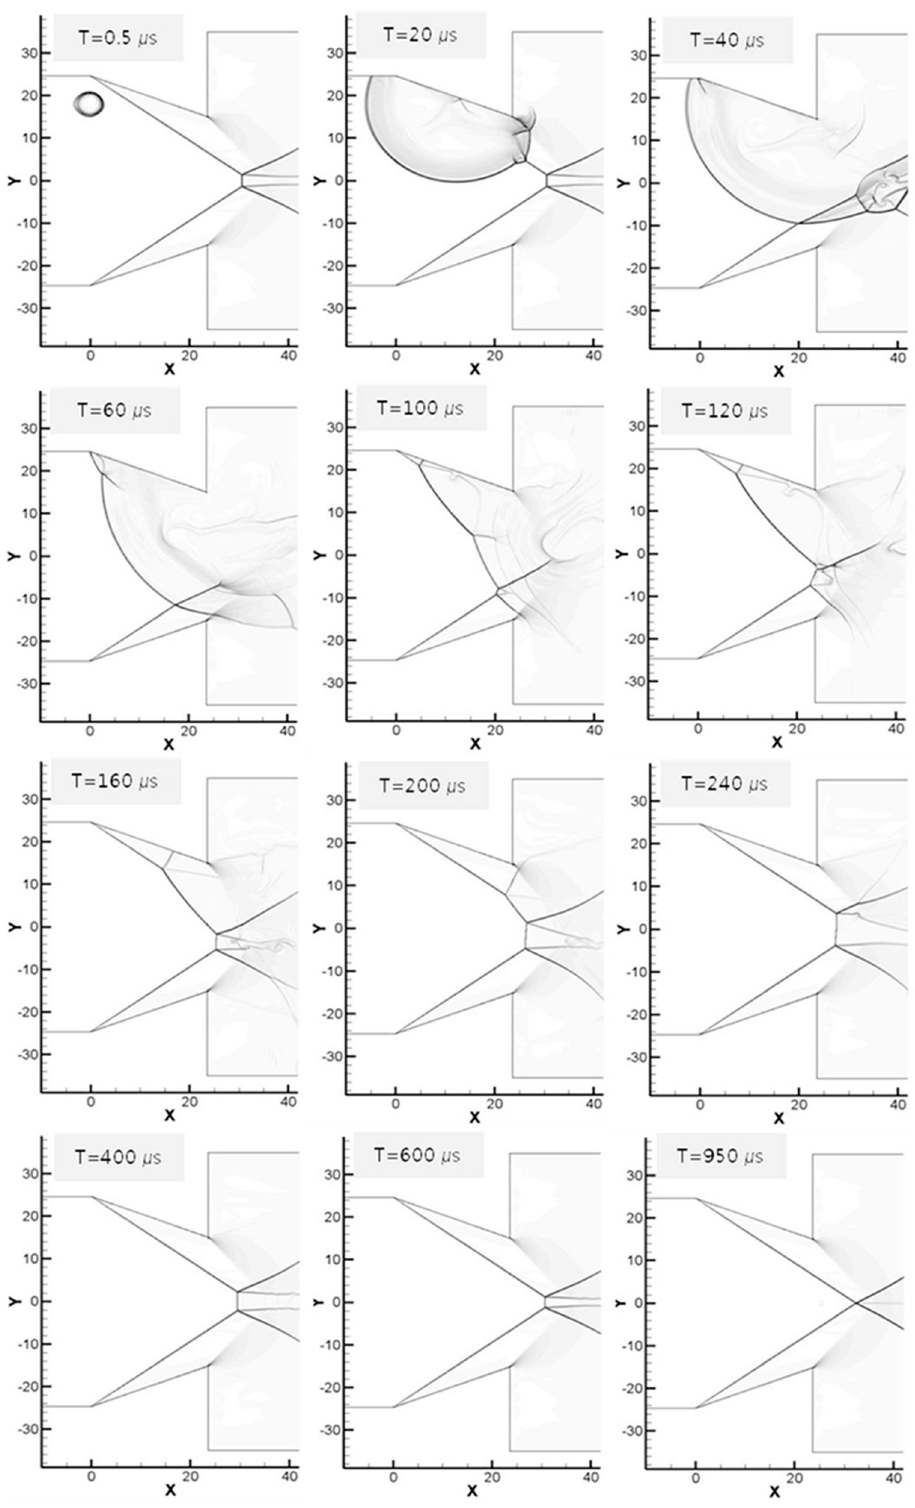
Figure 10. Interaction between blast wave and oblique shock, deposition upstream of the wedges. Energy: 215.0 mJ.